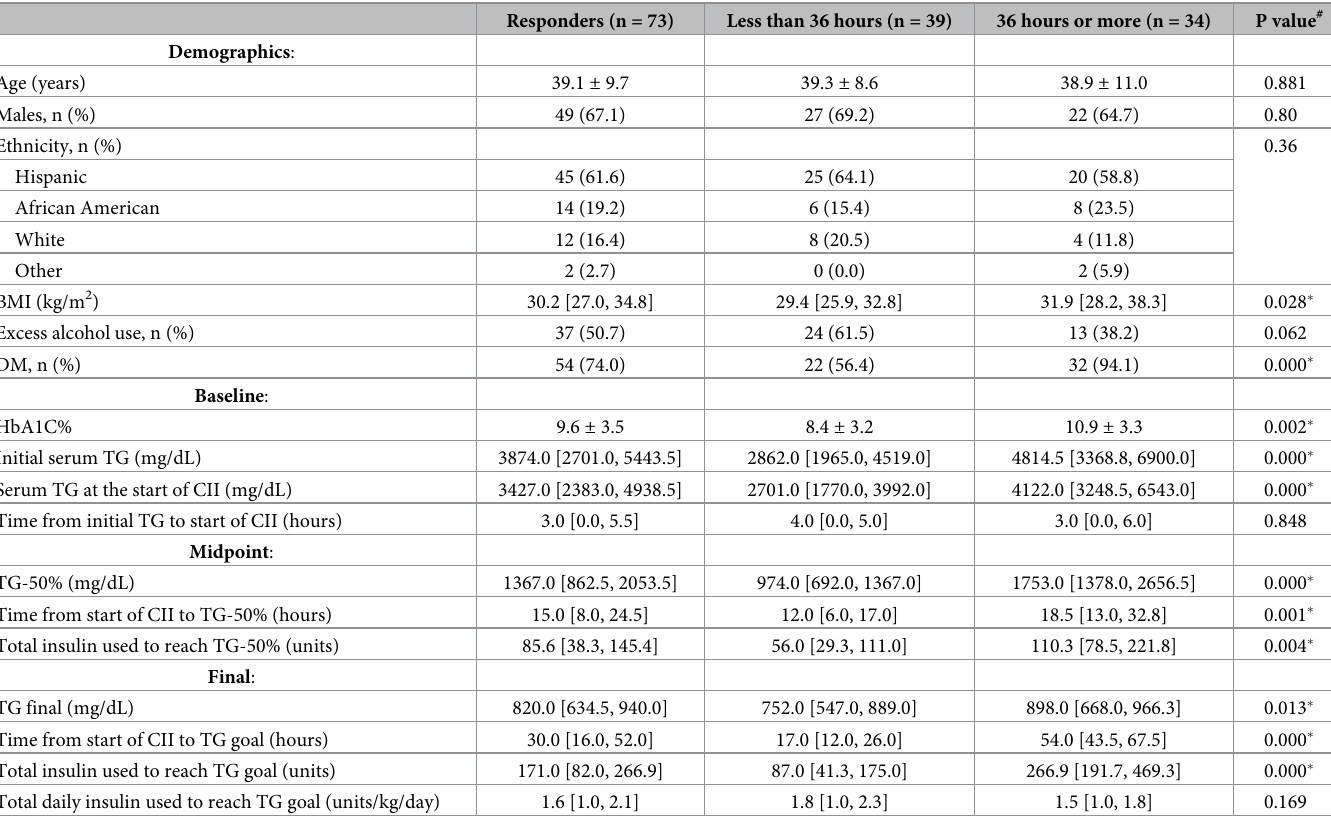
Table 2. Clinical and laboratory characteristics among the 73 responders who reached TG goal in less than 36 hours vs 36 hours or